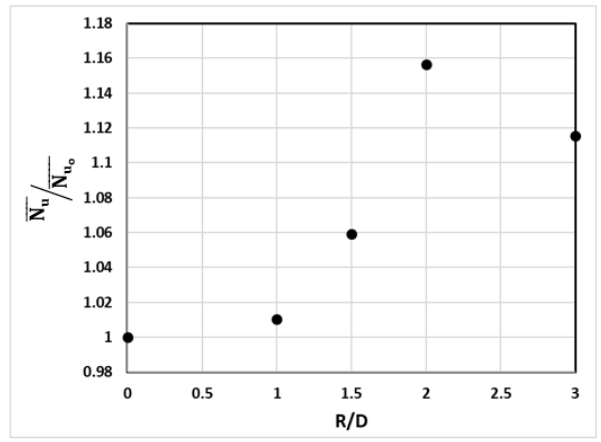
Figure 17. Effect of rib location on normalized average N u .